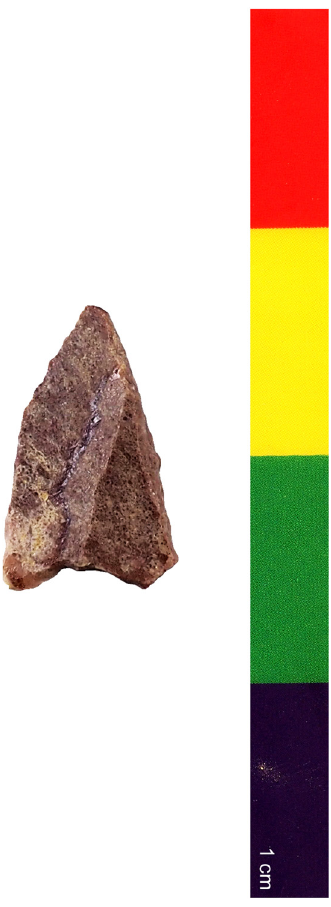
Figure 12: Broad micro - point with concave base retouch – site cluster 4 . Picture: C.